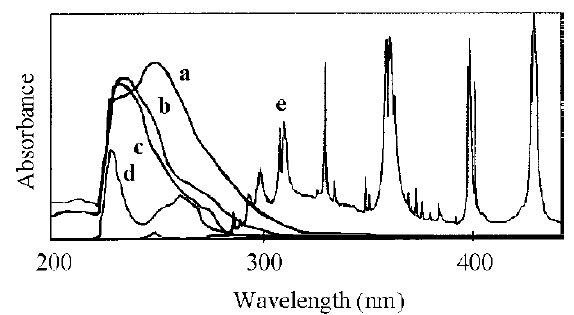
Figure 6. UV spectra of BAI (a), DPI (b), TPS (c), and PBSt- b -PSt (d) with the illumination intensity of irradiation of the high-pressure mercury lamp (e). Solvent: dichloromethane. Mn(PBSt- b -PSt) = 15,000- b